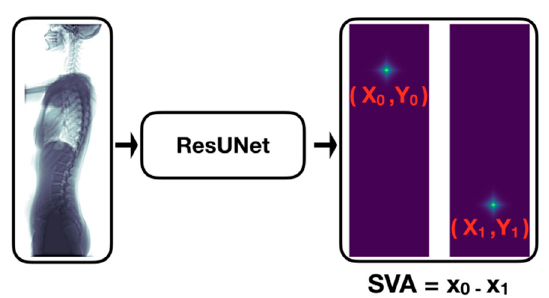
Figure 3. Automatic sagittal vertical axis (SVA) estimator. This estimator will turn an input image (tenor shape = 768 × 448 × 1) into predictions of two probability maps of landmarks (tensor shape = 768 × 448 × 2 ), which correspond to the C7 center and the posterior corner of the sacrum. The two landmarks are then localized from their corresponding maps and their horizontal difference (i.e., SVA) is calculated.